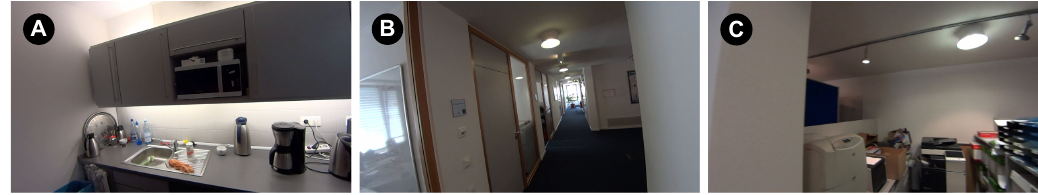
Figure 2 . Example images from kitchen (A), hallway (B), and printer area (C).